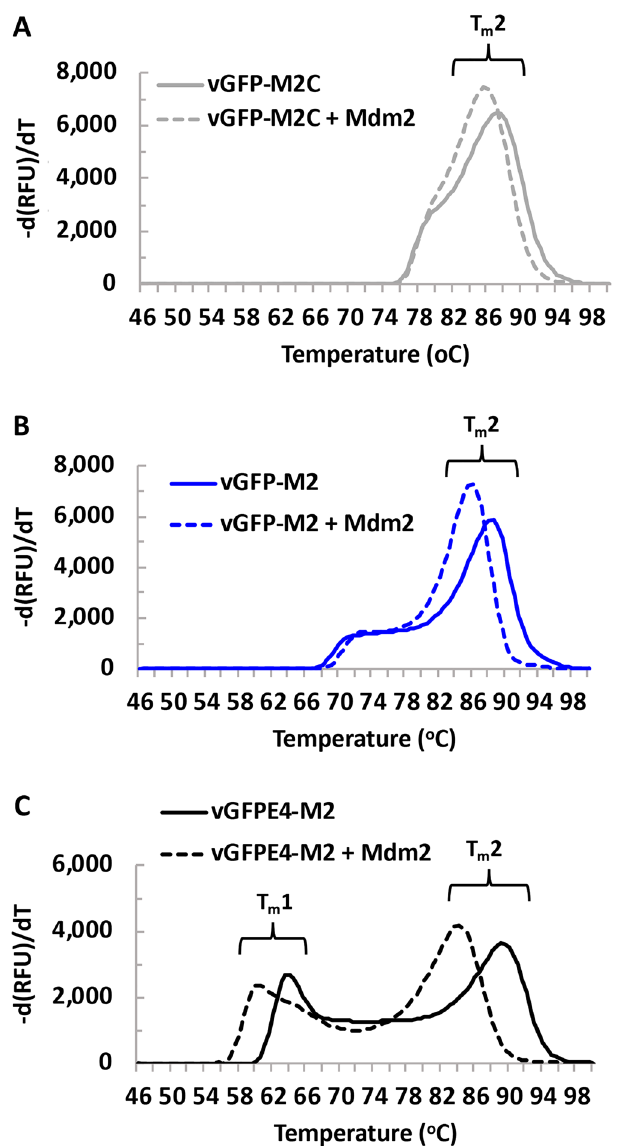
Figure 3. Thermal melt analysis of engineered vGFP proteins. The indicated vGFP variants were incubated alone (10 µM) or with Mdm2 (6–125) (100 µM) and fluorescence measured over a temperature range. Repeat experiments (n = 2) are shown in Supplementary Fig.